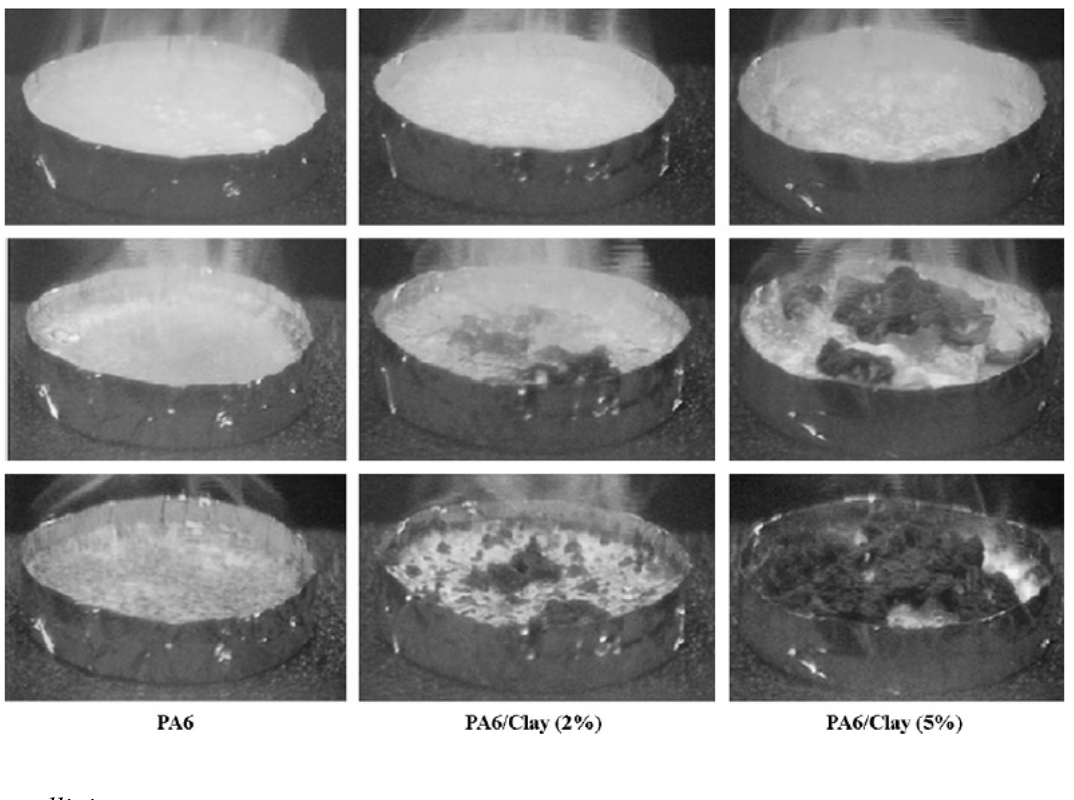
Figure 48. Flame behavior of the pure nylon, nylon nanocomposites with 2 and 5% of clay. The images have been taken at 100, 200 and 400s of the process. Reproduced from reference [173] with permission from